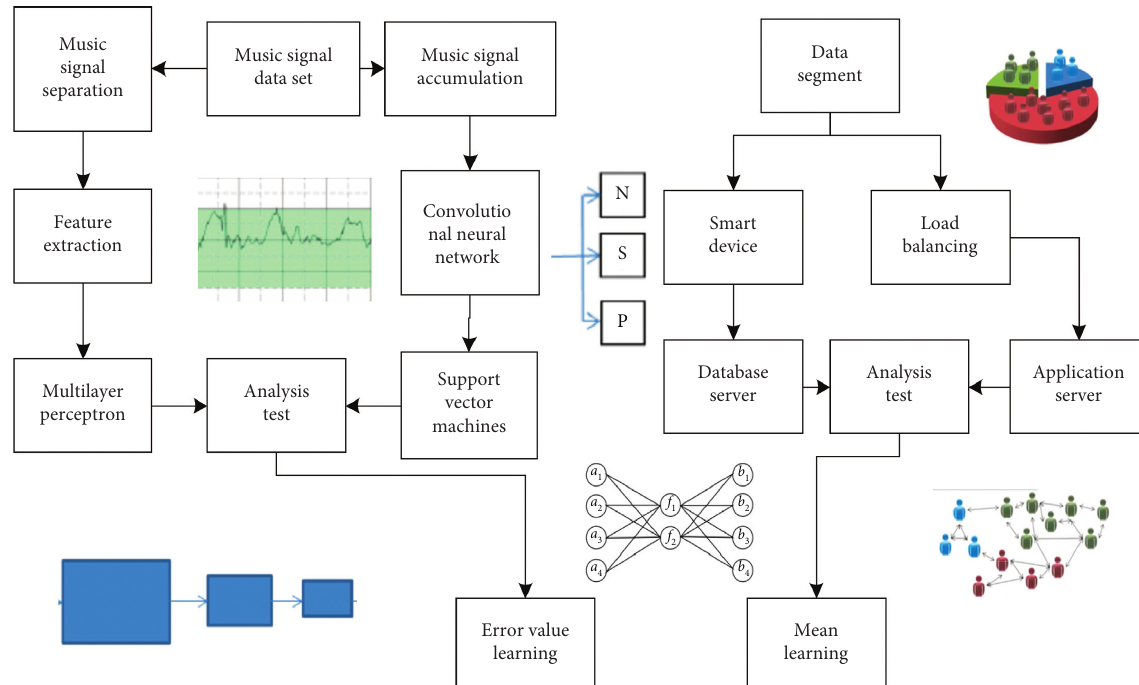
Figure 2: Intelligent model of somatosensory music therapy information feedback in deep learning